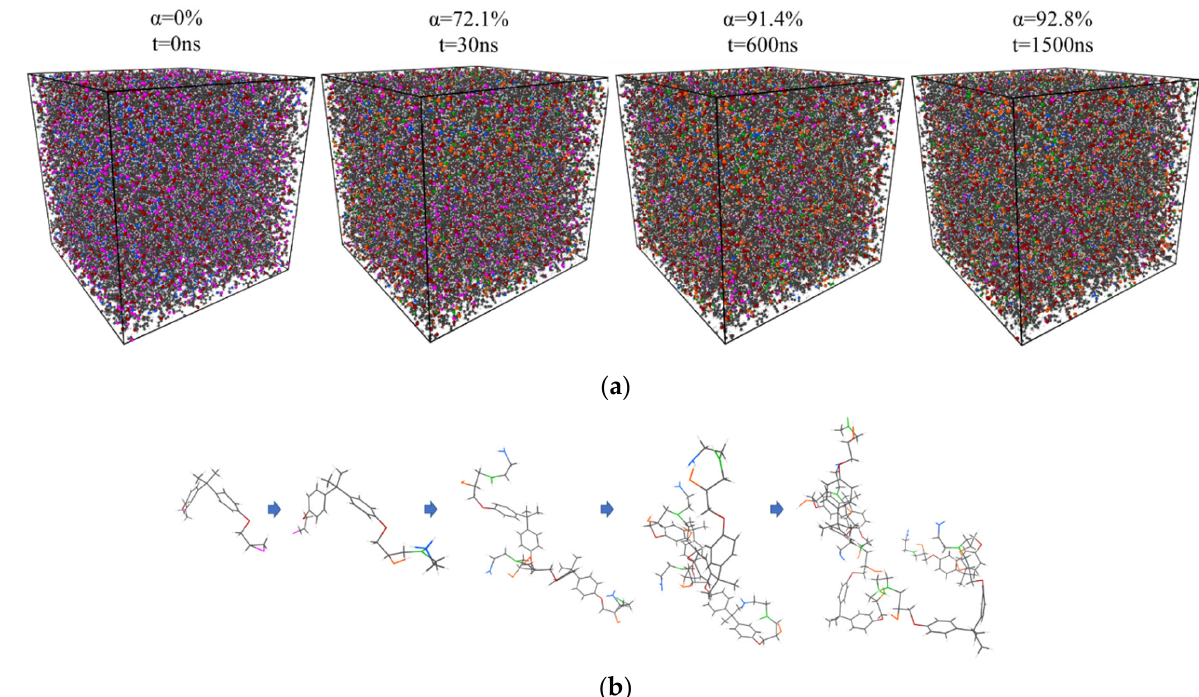
Figure 4. Changes in molecular structures during the curing process with the cutoff distance of 1.8 Å at 190 °C: ( a ) total view of the simulation box with periodic boundary, and ( b ) growth of the molecule as an example.